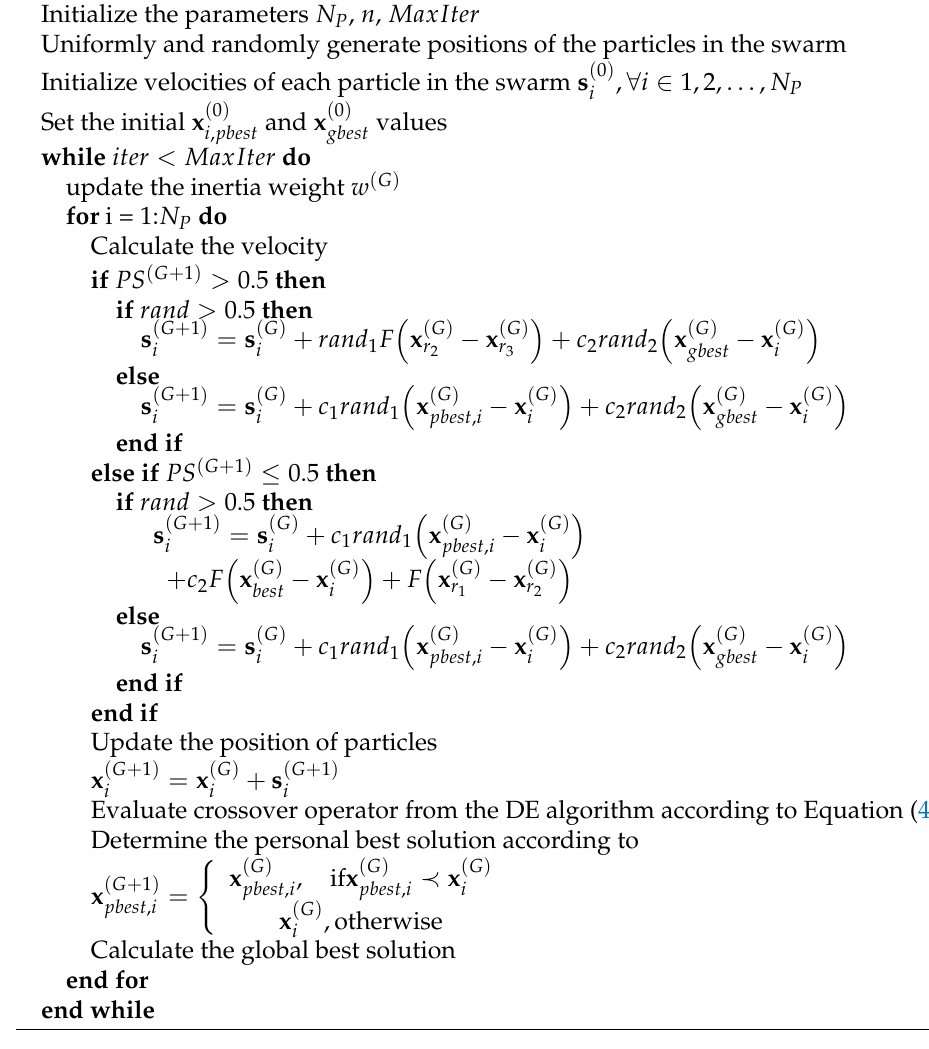
Algorithm 3 Pseudo-code of the proposed hybrid particle swarm differential evolution